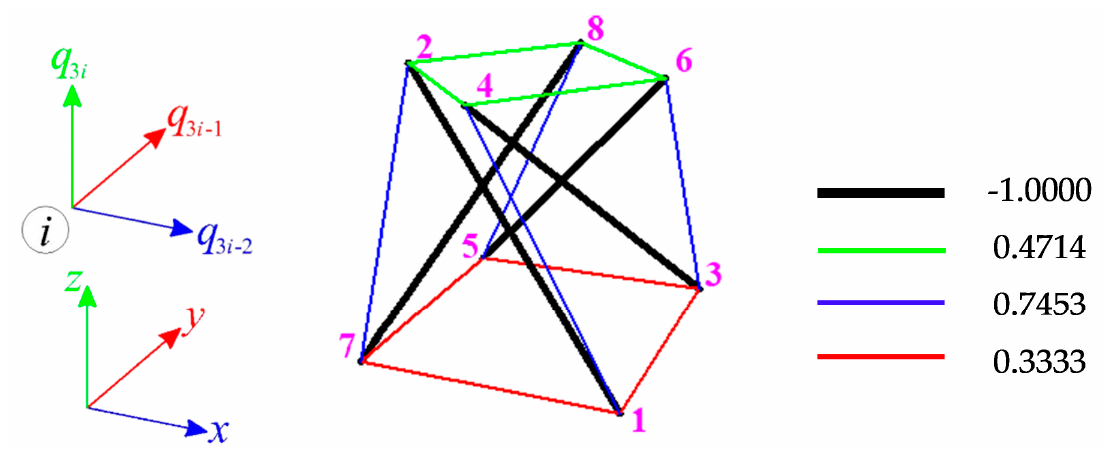
Figure 7. Normalised self-stress state of the single modified Quartex